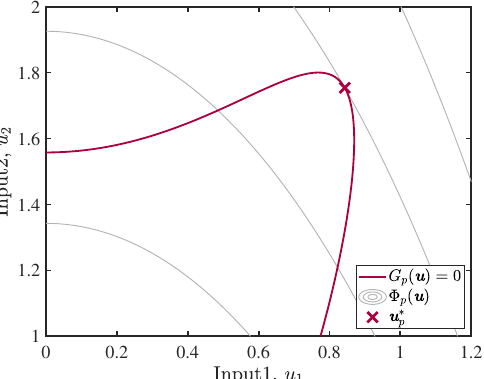
Figure 2. Example 2 plant NLP. The red cross represents the true optimum, the red line represents G p = 0, and the grey contour represents the plant objective